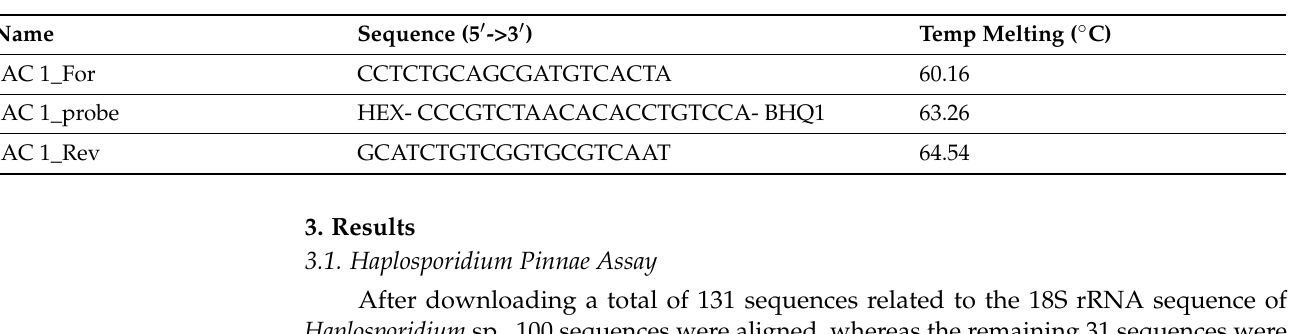
Table 3. Oligonucleotides and probe sequences for IAC 1 fragment and their melting